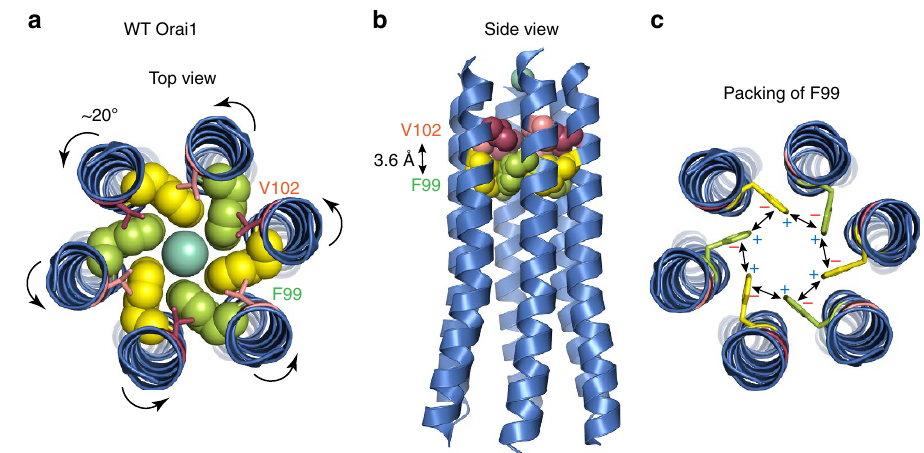
Figure 8 | Design features of the hydrophobic gate. ( a ) Top-view of the Orai1 channel pore based on the crystal structure of Drosophila Orai showing the predicted positions and orientations of V102 and F99. The side-chain of V102 is depicted as a stick and that of F99 in a space-filling model in this cartoon. Arrows denote the counter-clockwise rotation of the pore helix induced by STIM1. ( b ) Side-view of the Orai1 channel pore. Side-chains of V102 and F99 are shown in a space-filling model in this representation. The distance between the closest atoms of V102 and F99 of neighbouring subunits is B 3.6Å. ( c ) Potential edge-face cation– p interactions between F99 residues of neighbouring subunits. Pore helix rotation is expected to destabilize the interactions shown in b ) and c ), and release F99 side-chains to move away from the pore axis to open the